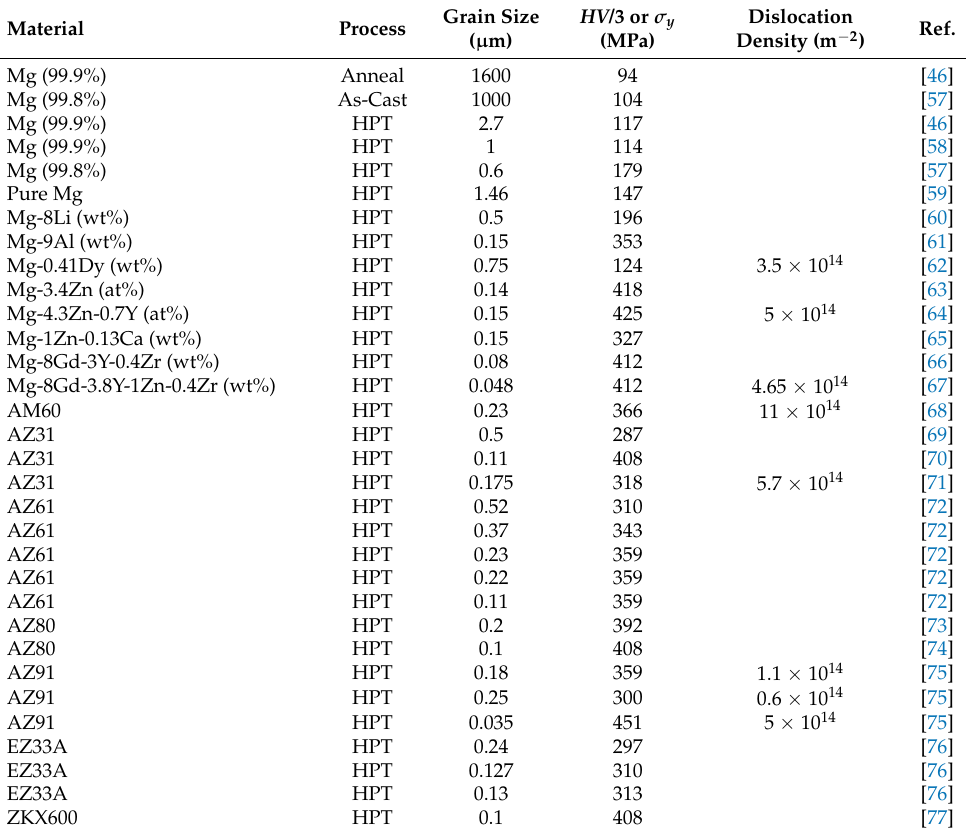
Table A1. Reported experimental data for grain size, yield strength or hardness divided